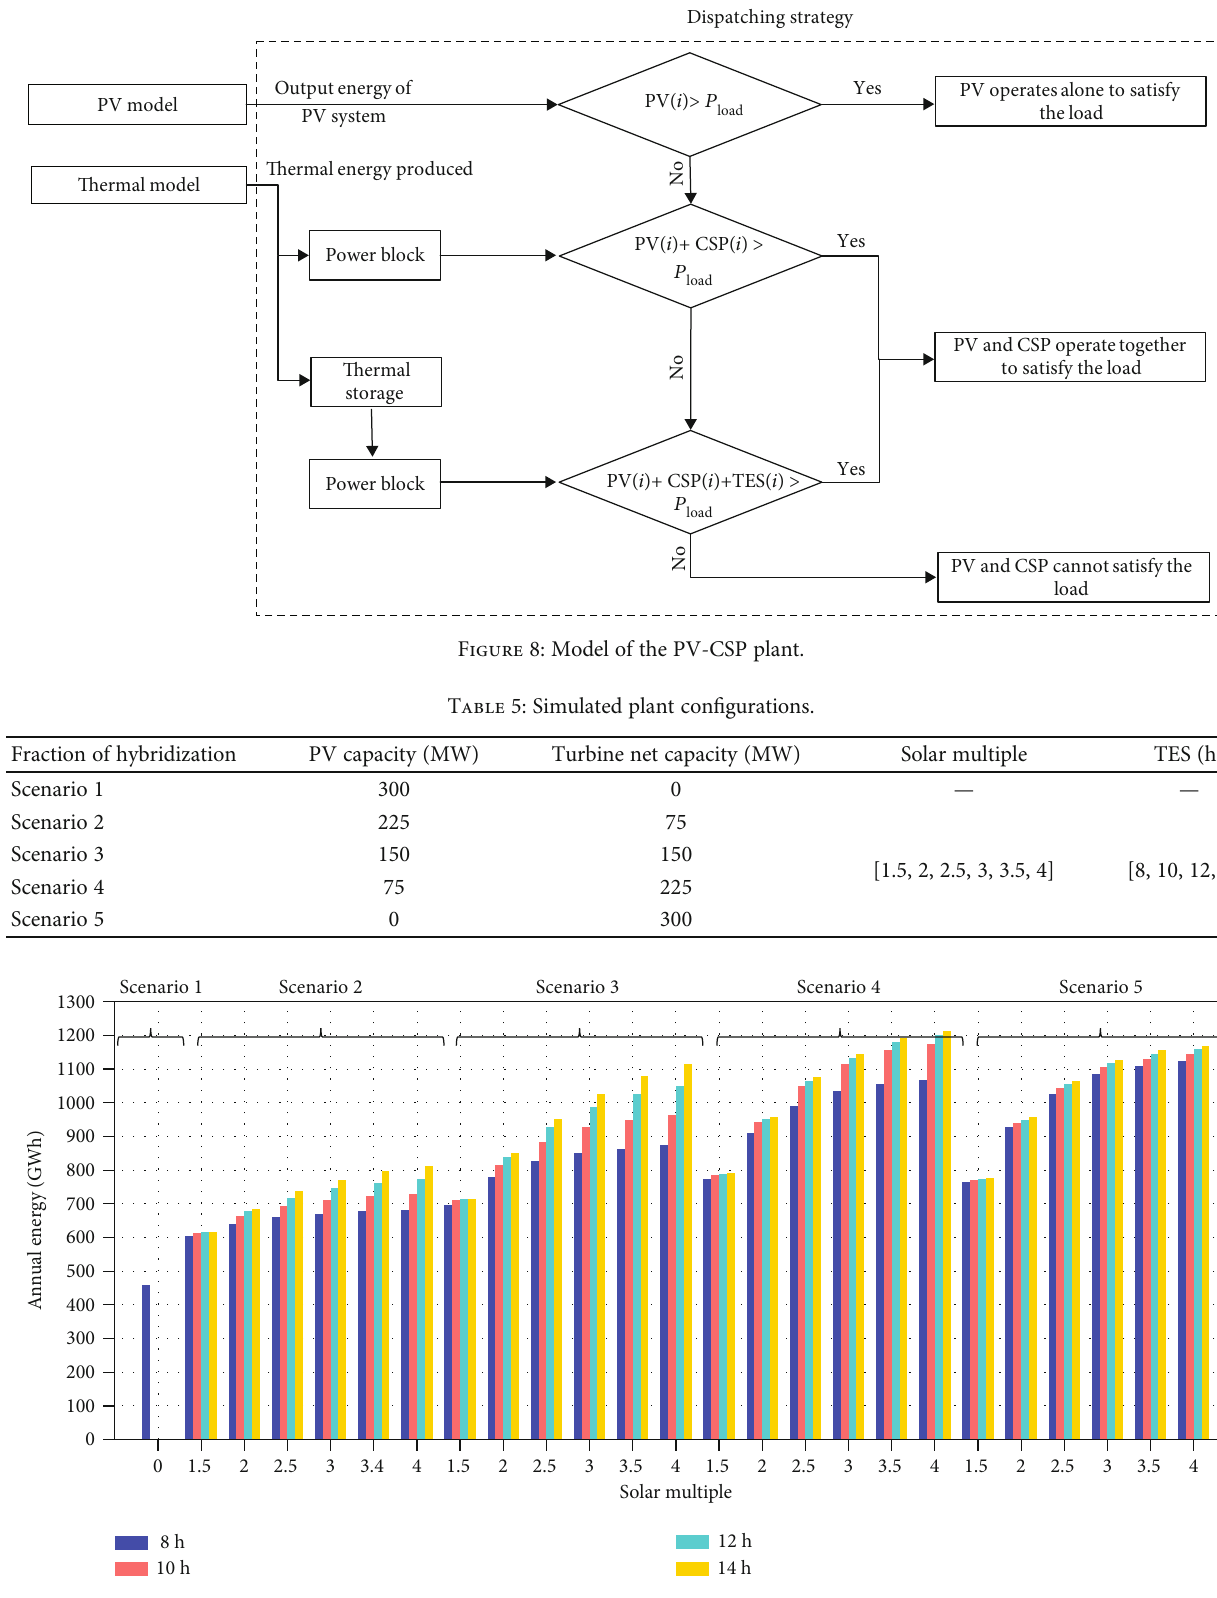
Figure 9: The annual energy from all simulated con fi